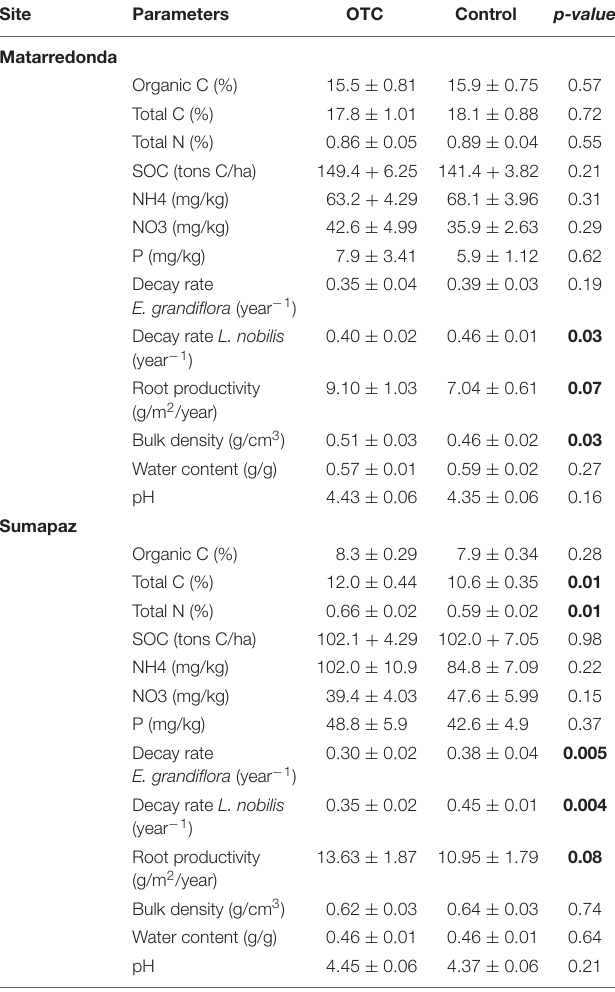
TABLE 1 | Soil related properties and processes in control and warmed (OTC)